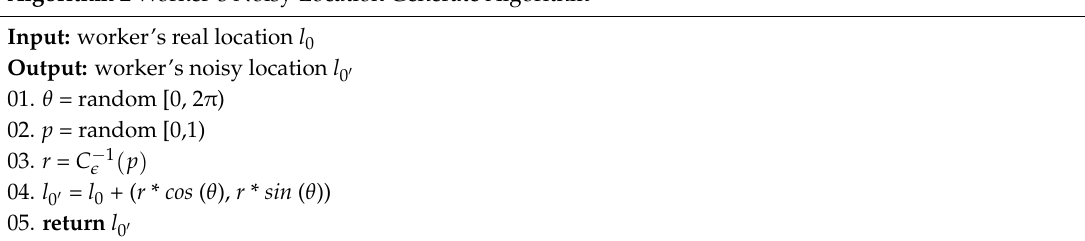
Algorithm 2 Worker’s Noisy Location Generate